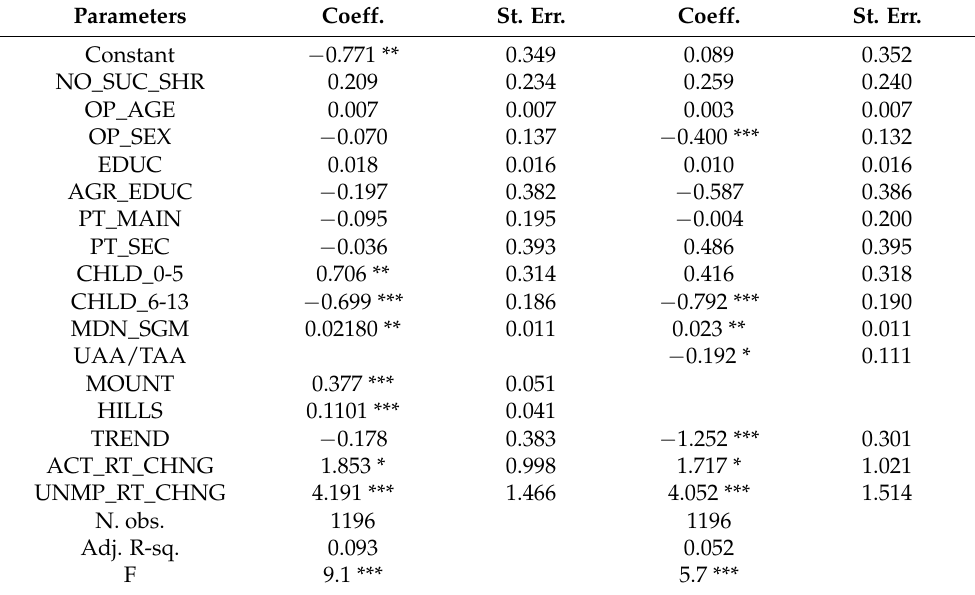
Table A3. Parameter estimates of the UAA decrease rate model using the all farms database. Parameters Coeff. St. Err. Coeff. St. Err.